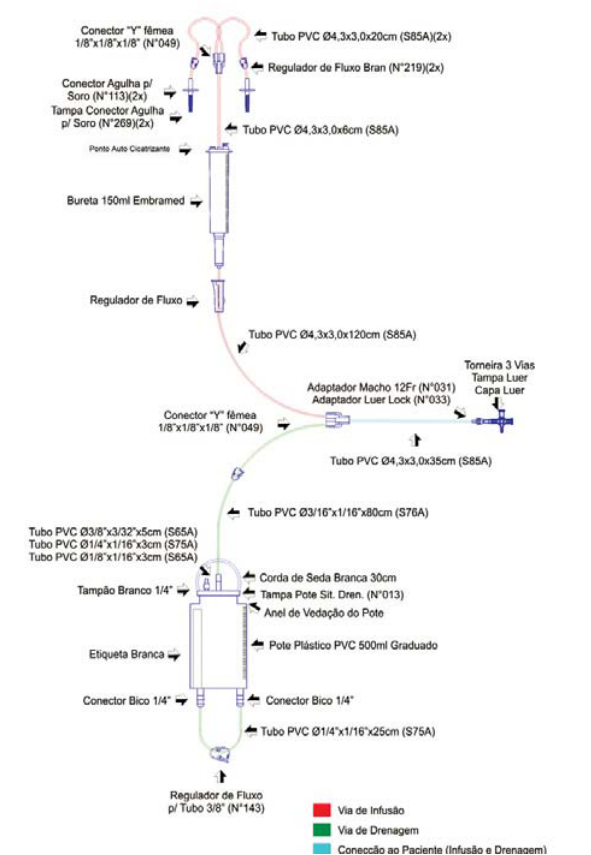
Fig. 1 – Esquema do sistema de diálise peritoneal pediátrico fechado. Observam-se os componentes e suas respectivas dimensões. PVC = Policloreto de